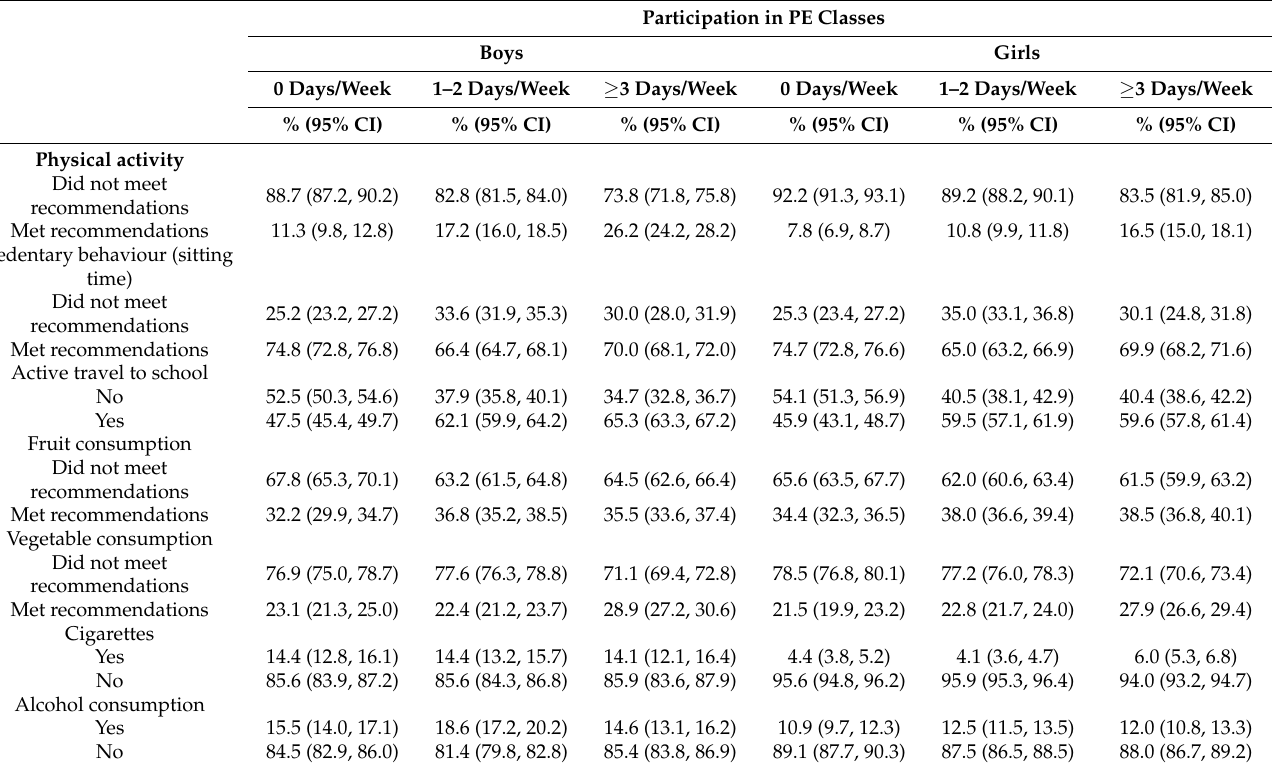
Table 2. Relationship between healthy behaviours and participation in PE classes. Participation in PE